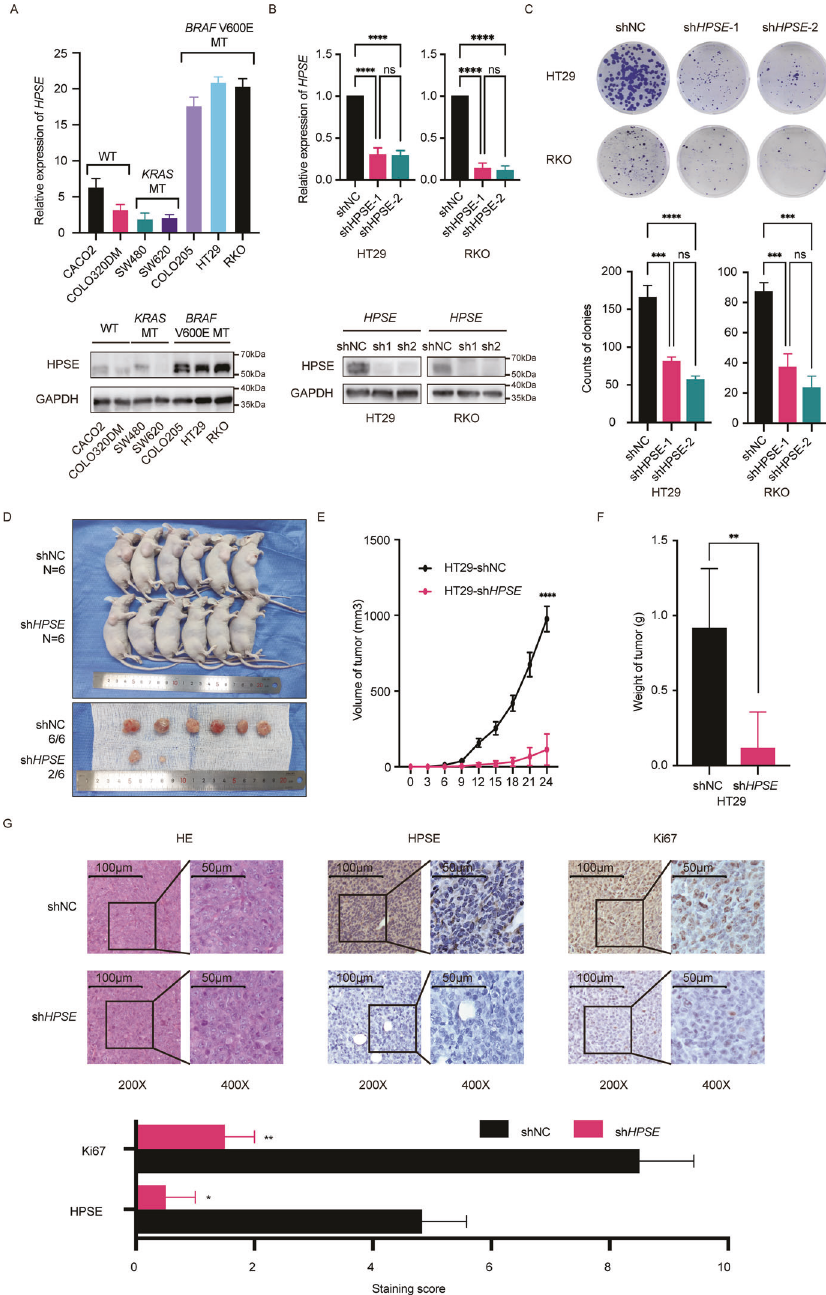
Fig. 3 Silencing HPSE inhibits proliferation of BRAF V600E-mutant CRC cells in vitro and in vivo. A Baseline relative expression level of HPSE in different CRC cell lines at mRNA level (top) and protein level (bottom). The same trend was observed in three independent repeated experiments. Representative results are shown. WT: KRAS/BRAF wild type; KRAS MT: KRAS mutant type; BRAF V600E MT: BRAF V600E mutant type. B Veri fi cation of knockdown of HPSE expression in HT29 and RKO at mRNA level (top) and protein level (bottom). The same trend was observed in three independent repeated experiments. Representative results are shown. Data are presented as mean ± standard deviation. NC negative control. C Representative images and statistical analysis of colony formation assay. Cells were seeded in six-well plates at 500 cells per well and cultured for 14 days. The same trend was observed in three independent repeated experiments. Data are presented as the mean ± standard deviation. D Subcutaneous xenograft models and tumors isolated on day 24. Each group contained six mice. Subcutaneous tumor formation rates of the two groups were 100% (6/6) in the control group and 33.3% (2/6) in the HPSE silencing group. E Growth curves of subcutaneous tumors in nude mice. Points and error bars represent mean ± standard errors. F Weight of subcutaneous tumors isolated from models on day 24. Data are presented as the mean ± standard deviation. G HE staining and IHC staining of HPSE and Ki67 in subcutaneous tumor tissues. Representative images and semi-quanti fi cation analysis are shown. Data are presented as the mean ± standard deviation. The student ’ s t -test was used to determine the P -value in two-group comparisons. One-way ANOVA analysis and Tukey ’ s test were used for multiple comparisons. **** P < 0.0001, *** P < 0.001, ** P < 0.01, * P < 0.05, ns P >